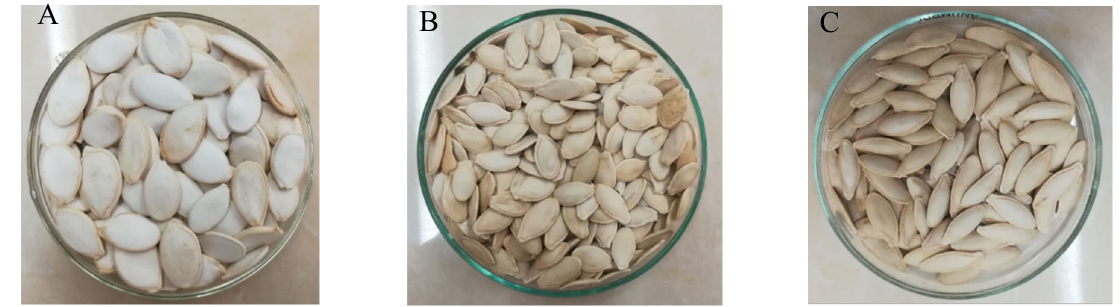
Figure 1. The Iranian landraces of Cucurbita sp. seeds were collected: Bagabakhi (BG) ( A ), Tanbal Ajili (TA) ( B ), Razan (RA) ( C ).